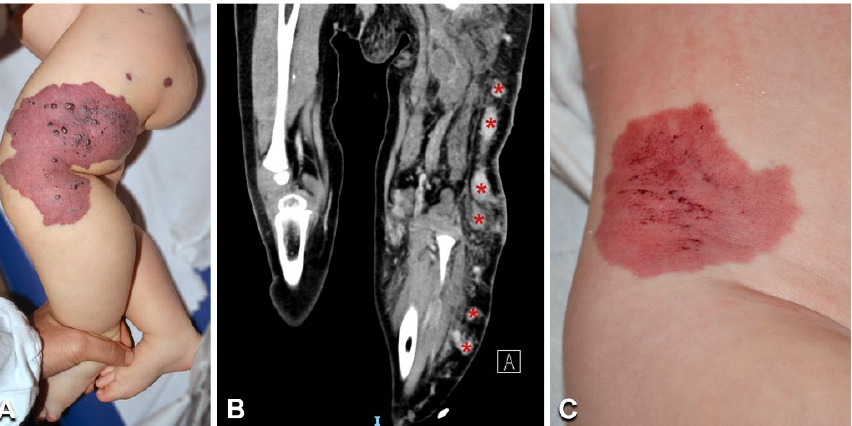
Figure 7. Clinical and imaging features of Klippel–Trenaunay syndrome: A 3-year-old girl (Table 1, n. 35) presents a combined capillary–venous–lymphatic malformation on her left buttock and lower limb (including the toes), with overgrowth ( A ). CT scan shows a persistent embryonic superficial vein ( B , asterisks). Note the clinical similarity of the vascular malformation in Klippel–Trenaunay ( A ) and CLOVES (Figure 6A) with an isolated combined capillary–lymphatic malformation of the right flank in a 1-year-old male infant (Table 1, n. 36) ( C ).